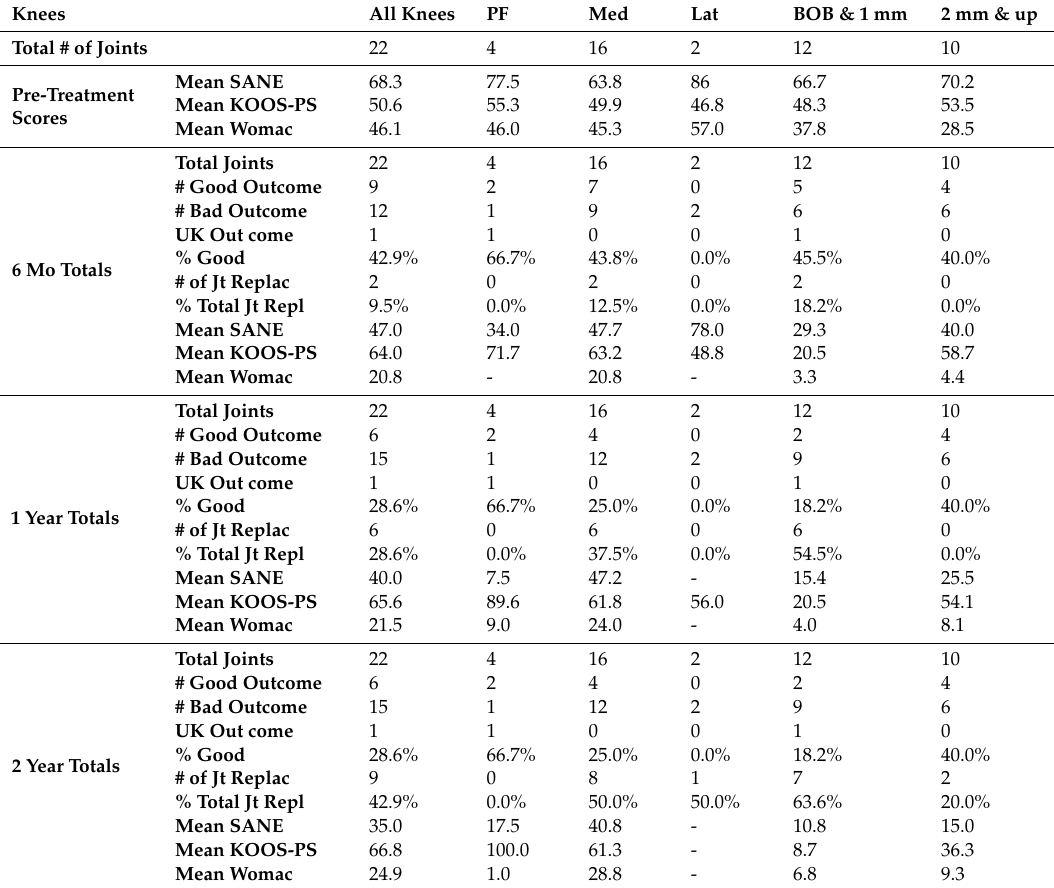
Table 2. Summary of treated knee